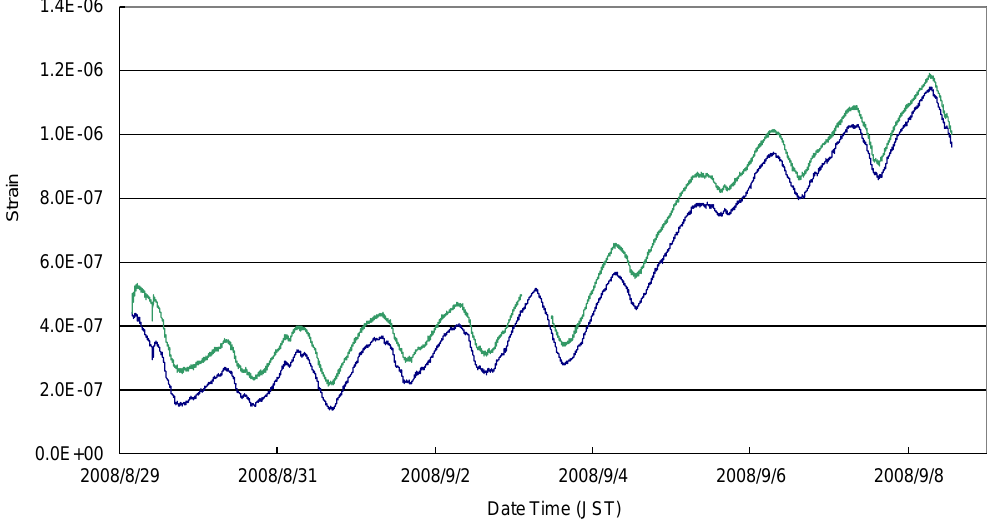
Figure 3. Displacement measurement in AIST tunnel. The blue line shows the result obtained from the two-color interferometer. The green line shows the result obtained from the one-color interferometer corrected using the refractive index of air calculated from environmental